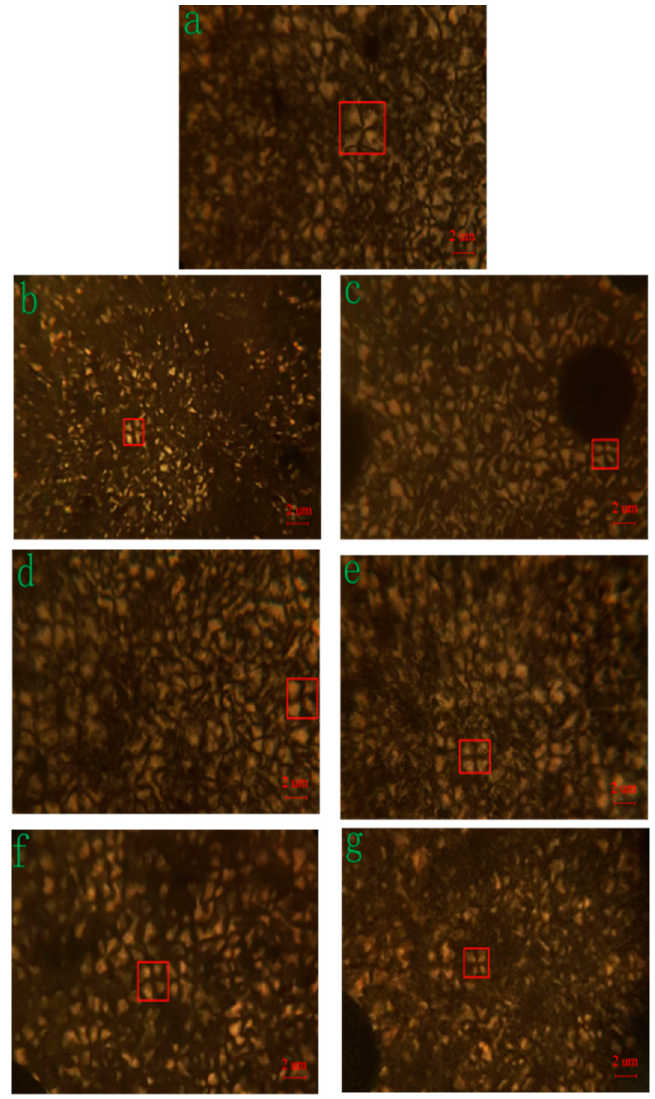
Figure 6. Polarized optical micrographs of MC nylon composites. Table 1. Nucleation density and grain size of MC nylon and MC nylon composites.